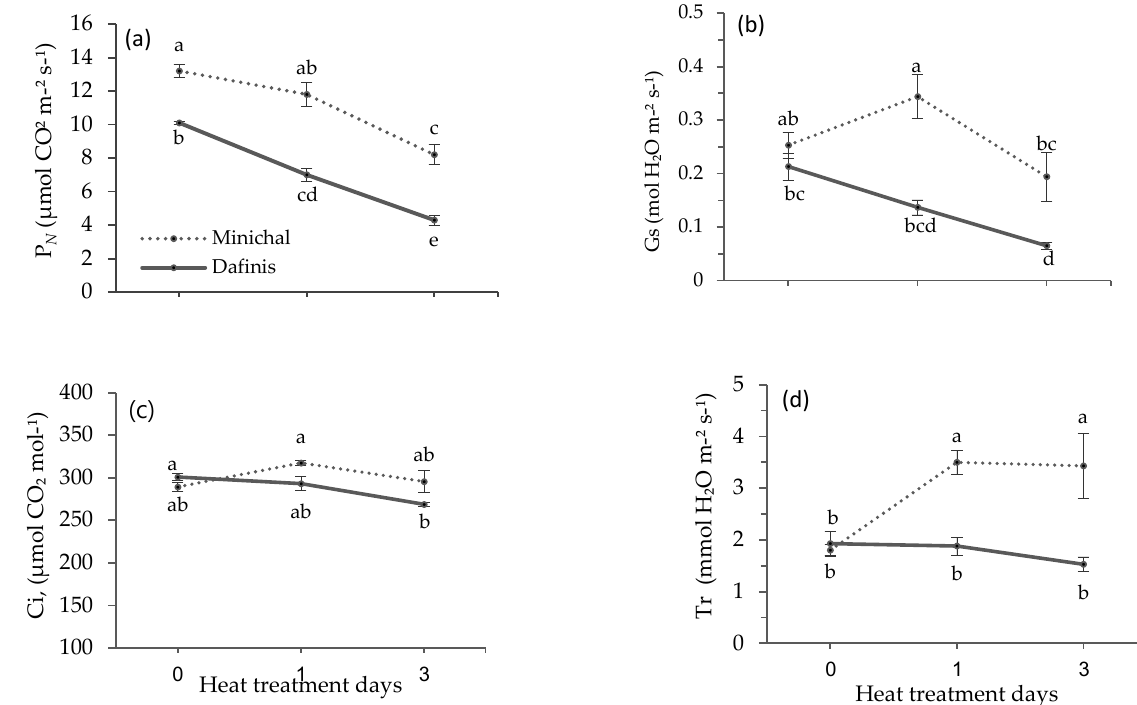
Figure 4. Effect of heat treatment (40 ◦ C) on photosynthetic rate ( a ), stomatal conductivity ( b ), intercellular CO 2 concentra- tion ( c ) and transpiration rate ( d ). The values are represented as means ± SE (n = 3). Different letters above bars indicate significant differences at p ≤ 0.05.